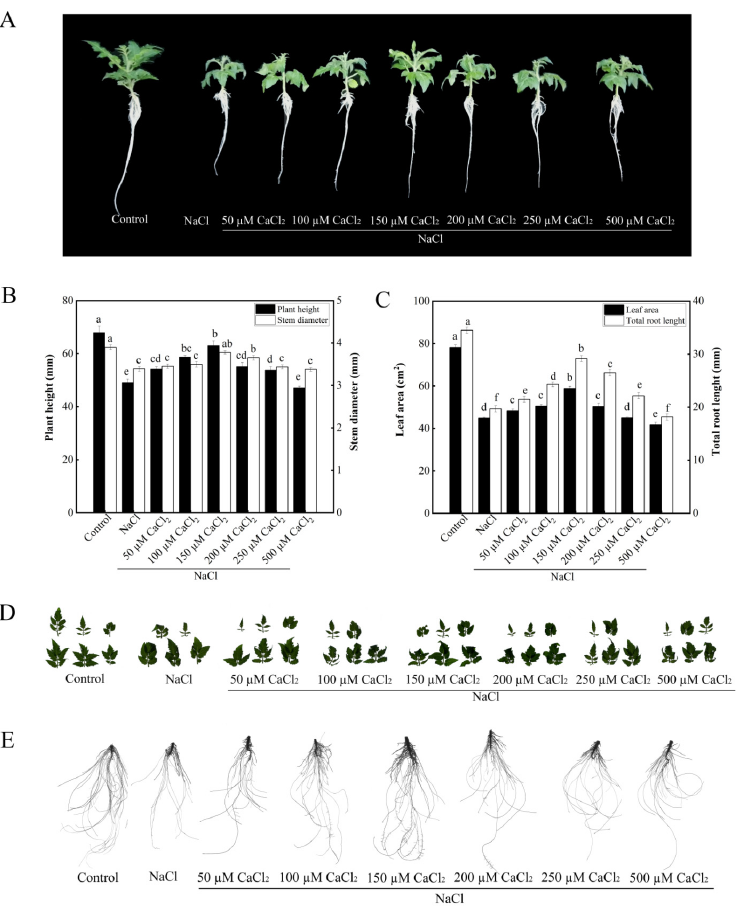
Figure 1. Effects of various concentrations of CaCl 2 on the growth of tomato seedlings under salt stress. ( A ): Plant phenotype; ( B ): plant height and stem diameter; ( C ): plant leaf area and total root length; ( D ): leaf phenotype; ( E ): root phenotype. The values (means ± SE) are the averages of three independent experiments ( n = 15). The columns labeled with different small letters indicate significant differences between treatments by Tukey’s multiple comparison test ( p < 0.05).